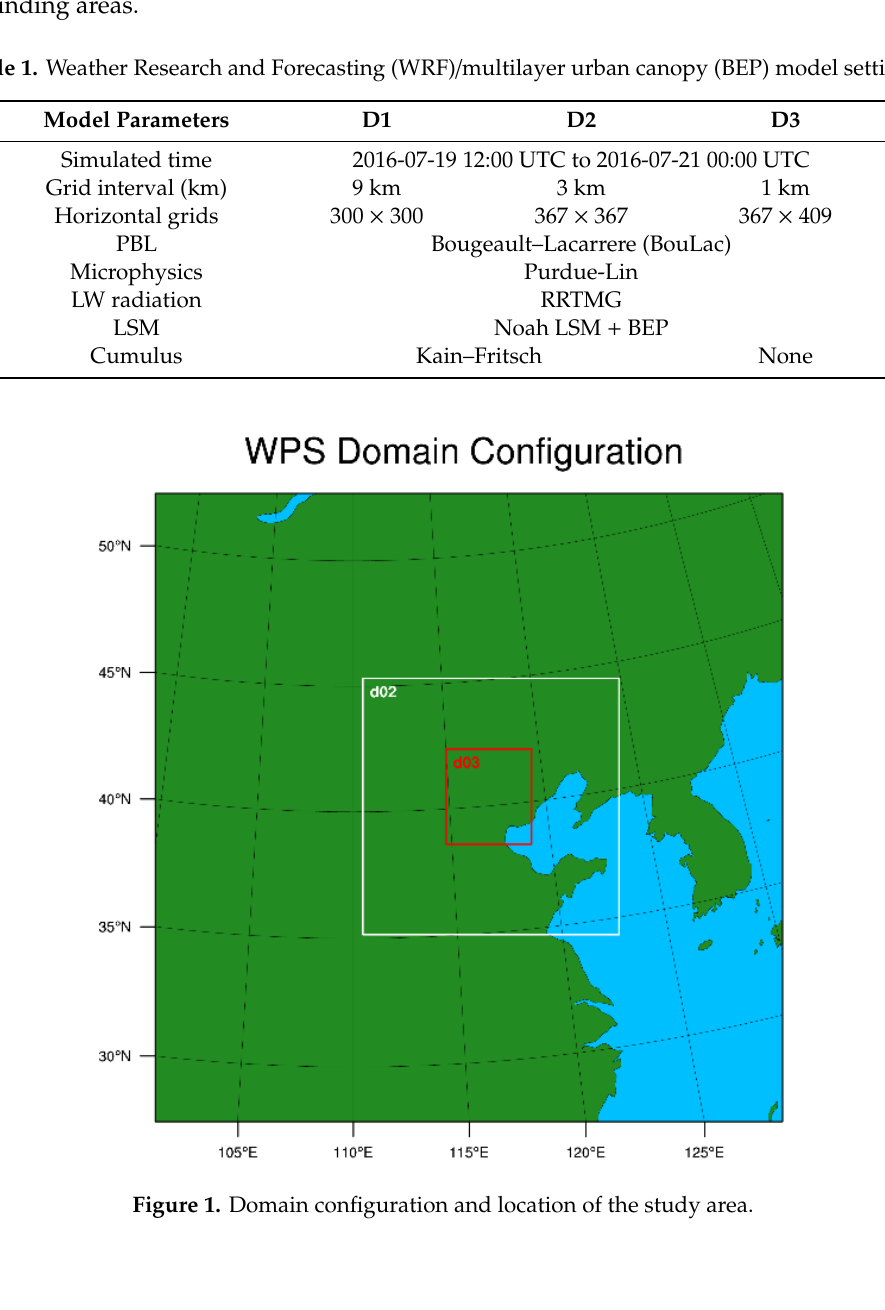
Figure 2. Land-use maps for D3 for the three experiments using the WRF/BEP model. ( a ) No urban test; ( b ) Urban06 test; ( c ) Urban16 test. 1—Evergreen Needleleaf; 2—Evergreen Broadleaf; 3— Deciduous Needleleaf; 4—Deciduous Broadleaf; 5—Mixed Forest; 6—Closed Shrubland; 7—Open Shrubland; 8—Woody Savanna; 9—Savannas; 10—Grassland; 11—Permanent Wetlands; 12— Cropland; 13—Urban and Built-up; 14—Cropland Mosaics; 15—Snow and Ice; 16—Bare Soil and Rocks; 17—Water Bodies; 18—Wooded Tundra; 19—Mixed Tundra; 20—Barren Tundra. 3. Results 3.1. Simulated Precipitation Figure 3 shows the observed and simulated 6 h accumulated precipitation from 02:00 UTC to 08:00 UTC on 30 July 2016. The Urban16 test simulation results (Figure 3d) are basically consistent with the observed precipitation (Figure 3a). In the Urban16 test, for most of the areas in Beijing and Tianjin, the 6 h accumulated precipitation is more than 50 mm in the heavy precipitation stage. One extreme precipitation area is located in the South of Beijing, and the range and intensity of the precipitation is consistent with the observations (Figure 3d). Therefore, the performance of the model in simulating the precipitation is satisfactory. Comparing the simulation results for the other three experiments confirms that the information regarding the underlying surface in the model can improve the accuracy of the simulation results.